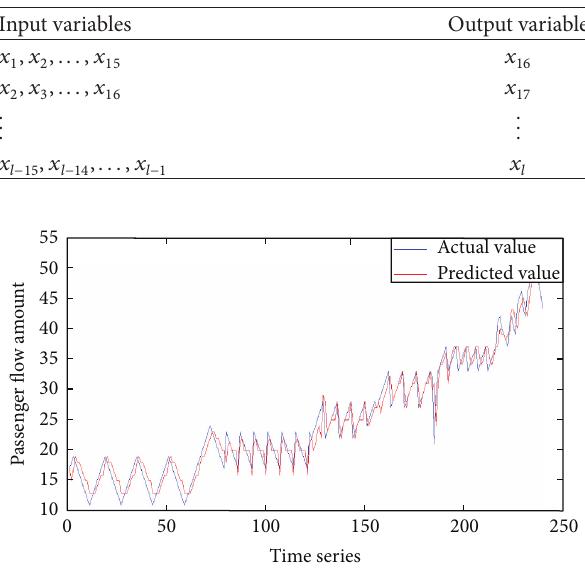
Table 1: Mapping structure between input variables and output variable.